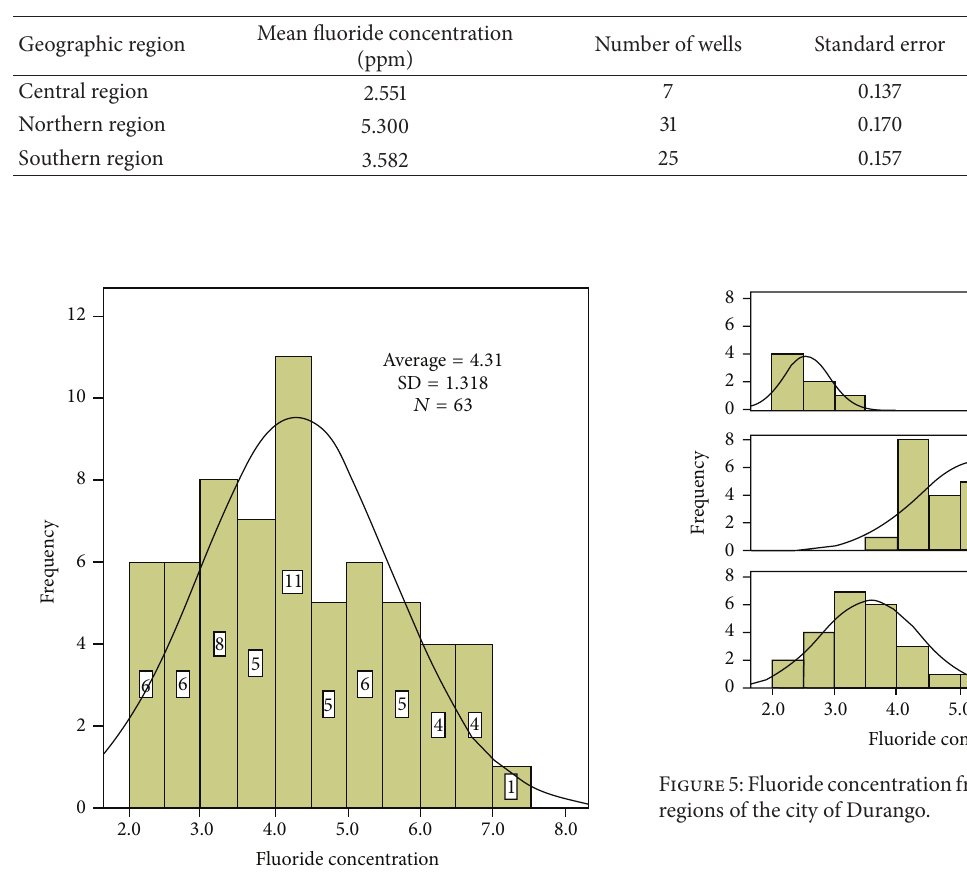
Figure 4: Fluoride concentration distribution in the city of Du- rango.